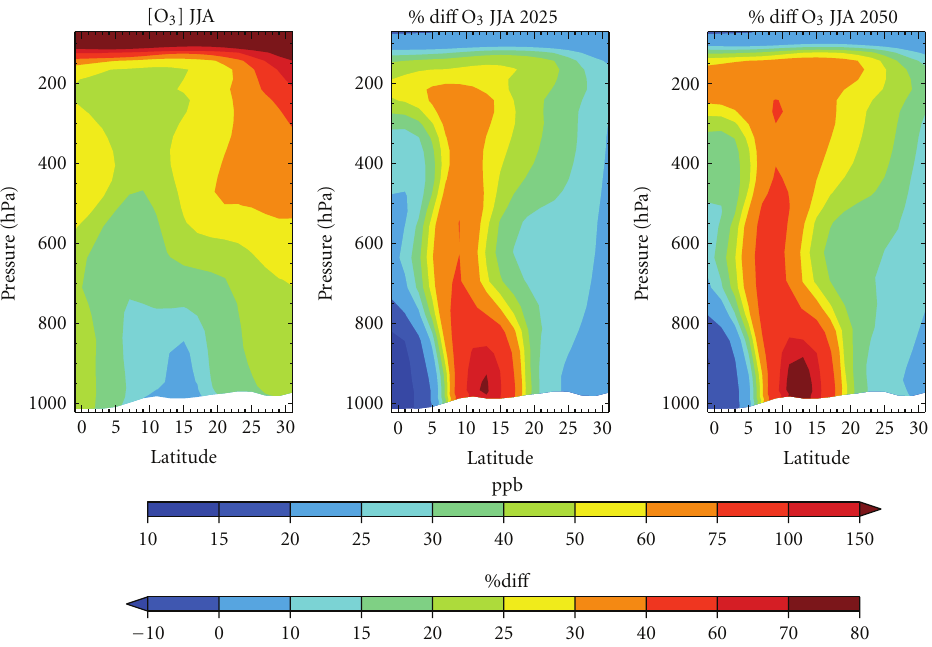
Figure 3: The seasonal zonal mean of tropospheric O 3 over West Africa during JJA during 2003 averaged between 23 ◦ W–10 ◦ E. Percentage di ff erences are shown when compared against the A1B 2025 (middle) and A1B 2050 (right) simulations.